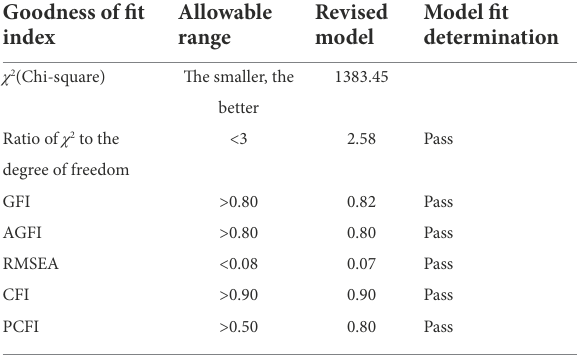
TABLE 8 Overall Model Fit